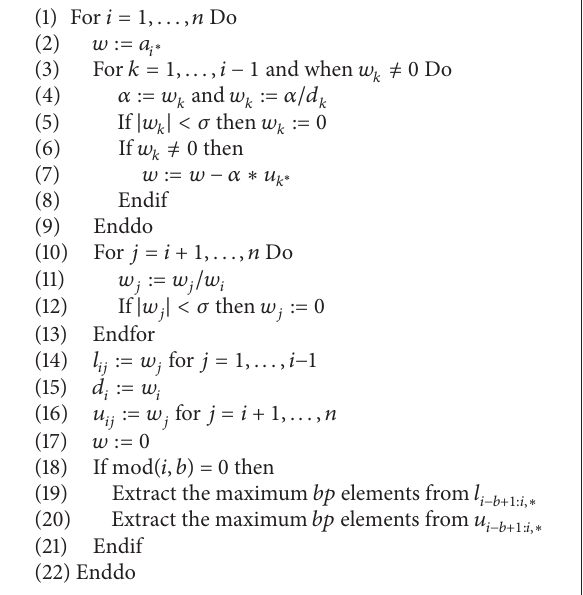
Algorithm 2: Algorithm MRILDU( 𝑏,𝑝, 𝜎